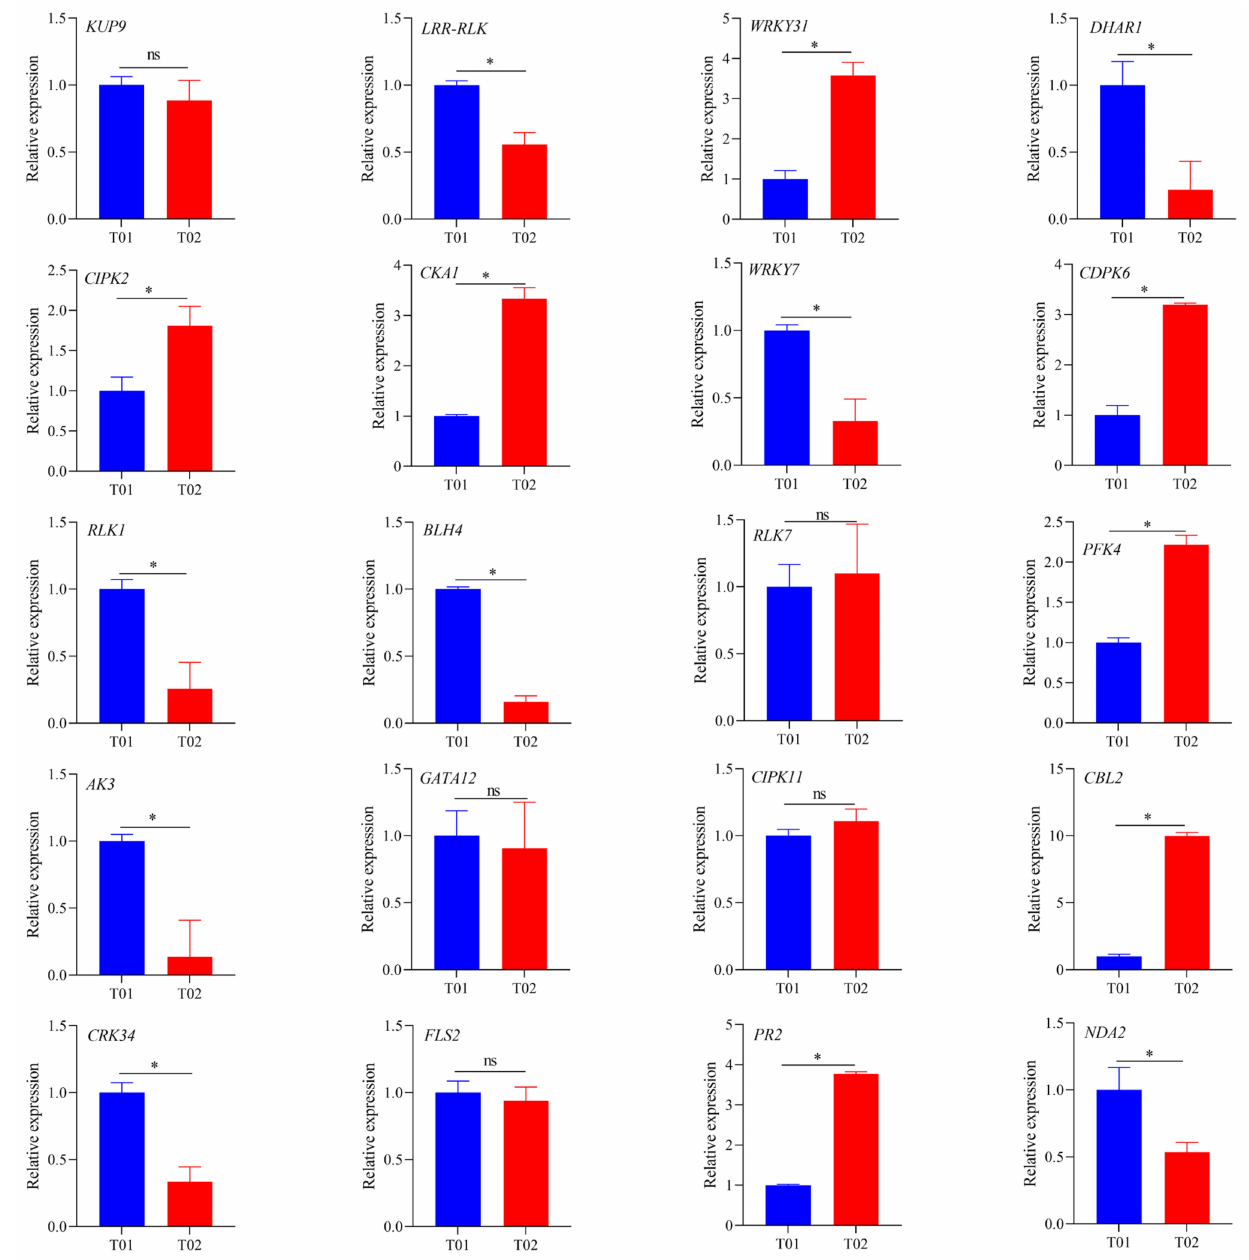
Figure 6. The relative expression of 20 candidate genes by qRT-PCR. The experimental expression level data are normalized to the expression level of the internal reference gene glyceraldehyde-3- phosphate dehydrogenase ( GAPDH ). T01 (blue) and T02 (red) represent the SBS-resistant parent YT93-159 and the SBS-susceptible parent ROC22, respectively. The bar is the standard error of each group of processing data (n = 3). * Duncan’s new multiple range test indicates that candidate genes are significantly differentially expressed at the level of p < 0.05 between T01 and T02. ns = Not